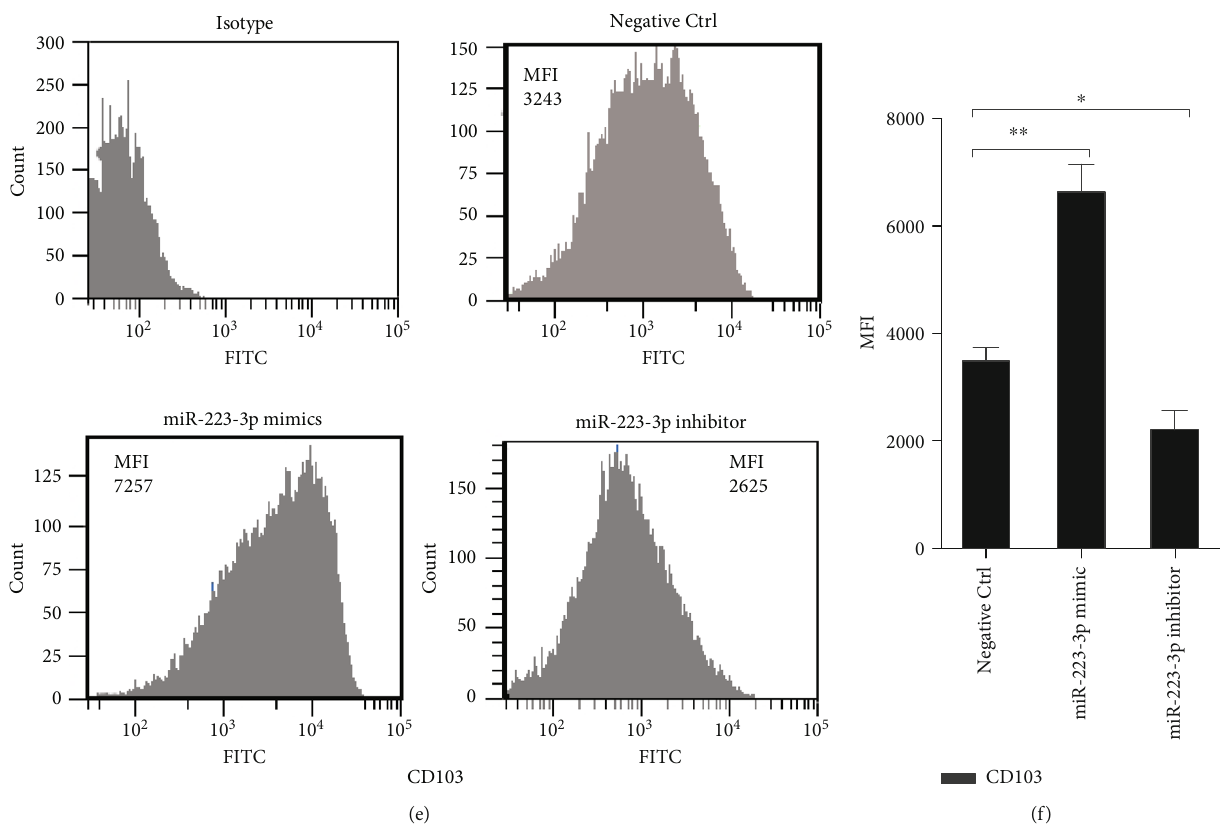
Figure 5: miR-223-3p regulated DC-initiated CD4+ T cell di ff erentiation Immature mouse DCs were transfected with the miR-223-3p mimic (a, b), mimic control, miR-223-3p inhibitor (c, d), or inhibitor control, at a fi nal concentration of 50 nM. After 24h, DCs were stimulated with 100 μ g/ml OVA for 24 h. Puri fi ed CD4+ T cells were cocultured with the transfected DCs at a ratio of 1 :10 (DC/T cells). After 4 days, cells were collected and stained with anti-CD4-APC, followed by intracellular staining with FITC-conjugated anti-Foxp3, FITC-conjugated anti-IL-17A, PE-conjugated anti-GATA-3, or PE-conjugated anti-T-bet, respectively. The cells were then analyzed by fl ow cytometry. The bar chart indicated the speci fi c transcription factor of T cells in the gate of CD4+ cells in each group. Data were shown as mean ± SD of three independent experiments. t -test, ∗ P < 0 : 05 , ∗∗ P < 0 : 01 . (e) The e ff ect of miR-223-3p on CD103 expression in OVA-treated DCs. Immature DCs were transfected with the miR-223-3p inhibitor (50 nM), miR-223-3p mimic (50 nM), or negative control (50 nM) for 24 h, respectively. DCs were incubated with OVA (100 μ g/ml) for 24h, and cells were collected for fl ow cytometry analysis (gating for CD11c) to determine CD103 expression levels. (f) MFI value presented CD103 expression levels of the three groups. Data were presented as mean ± SD of three independent experiments. Post hoc Tukey ’ s HSD test, ∗ P < 0 : 05 , ∗∗ P < 0 : 01